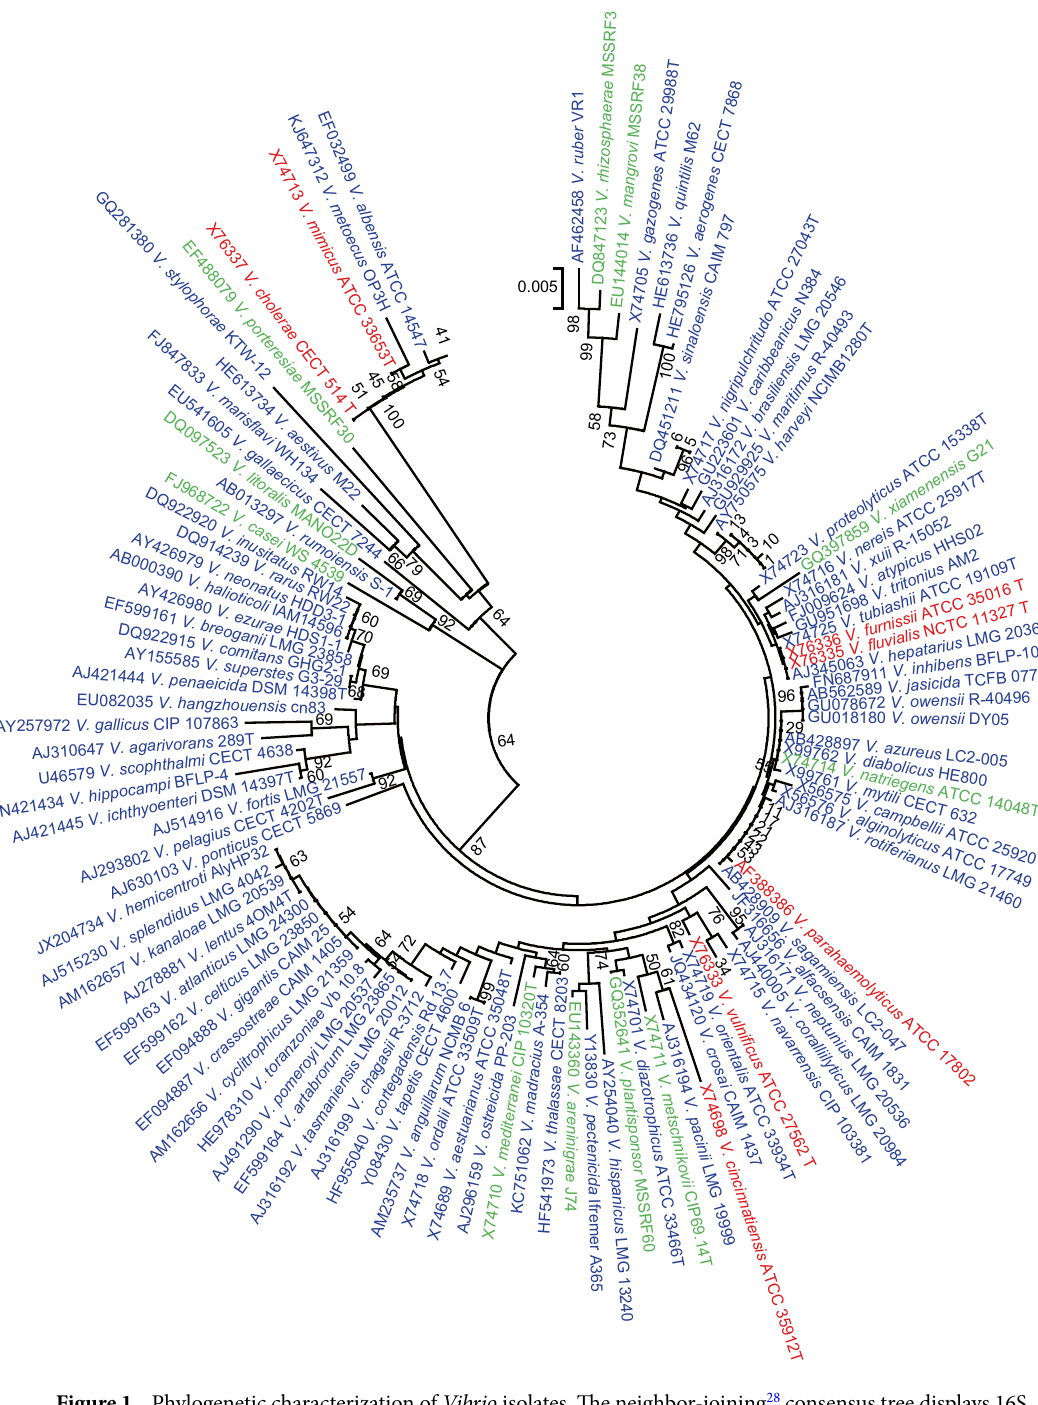
Figure 1. Phylogenetic characterization of Vibrio isolates. The neighbor-joining 28 consensus tree displays 16S rRNA gene sequences (≥ 1200 bp) of (i) 18 Vibrio isolates and (ii) all Vibrio type strains with good sequence quality (103 strains in total) downloaded from the Ribosomal Database Project 27 (RDP, http:// rdp. cme. msu. edu/). The phylogenetic analyses were performed in Mega 7 29 using the Kimura-2-parameter 30 method with Gamma distribution (0.10) to calculate the evolutionary distances. The bootstrap values indicated at the nodes are based on 1 000 bootstrap replicates 31 . Branch values lower than 50% are hidden. The scale bar indicates an evolutionary distance of 0.005 nucleotide substitution per sequence position. Black, red, blue and green colors indicate the isolates of this study and the reference strains from human-related, aquatic and terrestrial/plant sources of isolation, respectively. Strains from (inter)tidal area, coastal sediment, mangrovesoil and salt marsh mud are marked in green. The name of each reference strain is preceded by the accession